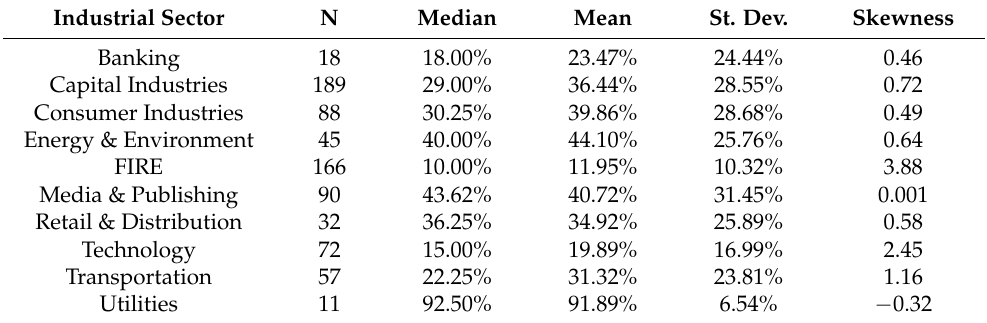
Table 4. Summary statistics of recovery rates according to the industrial sector of the bond issuer.